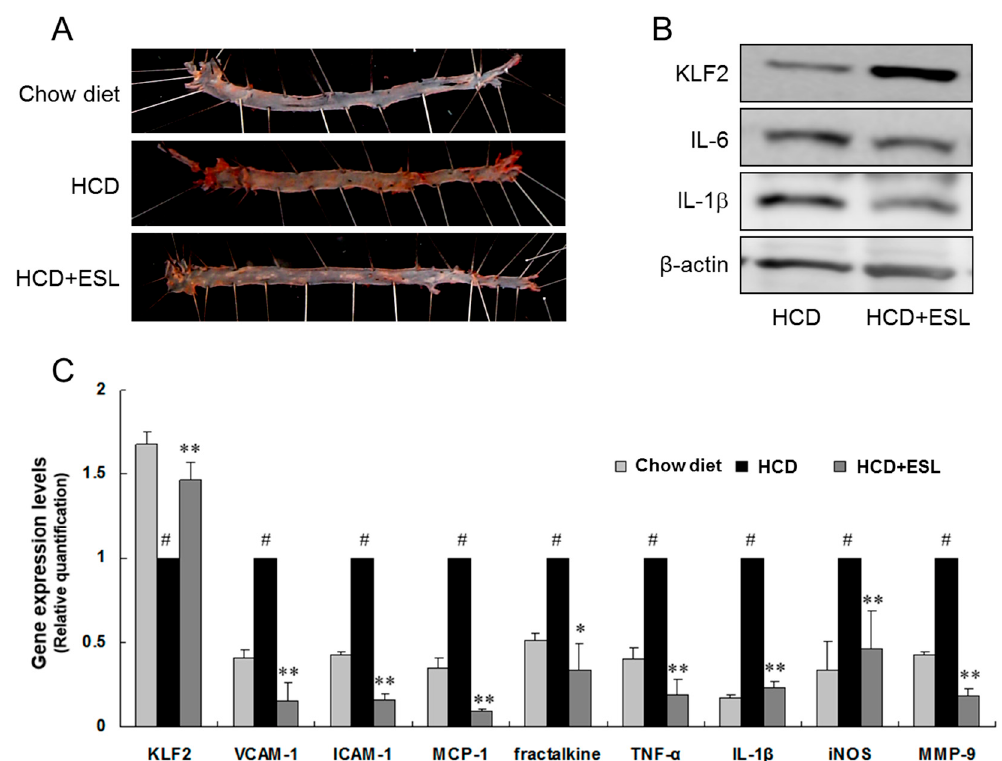
Figure 4. Effects of ESL on lipid deposition and expression of atherogenic markers in the aortas of LDLR − / − mice fed a HCD for 12 weeks: ( A ) representative photographs of an oil red O-stained whole aorta (en face) from each group are shown; ( B ) the protein levels of KLF2, IL-6, and IL-1 β were measured by Western blot analysis; and ( C ) the mRNA expression of the indicated targets was determined by real-time qRT-PCR. # p < 0.01 vs. the chow diet group. * p < 0.05 and ** p < 0.01 vs. the HCD group. Chow diet, chow-fed group; HCD, high-cholesterol diet-fed group; HCD + ESL, 1% ( wt / wt diet) ESL supplemented HCD-fed group.